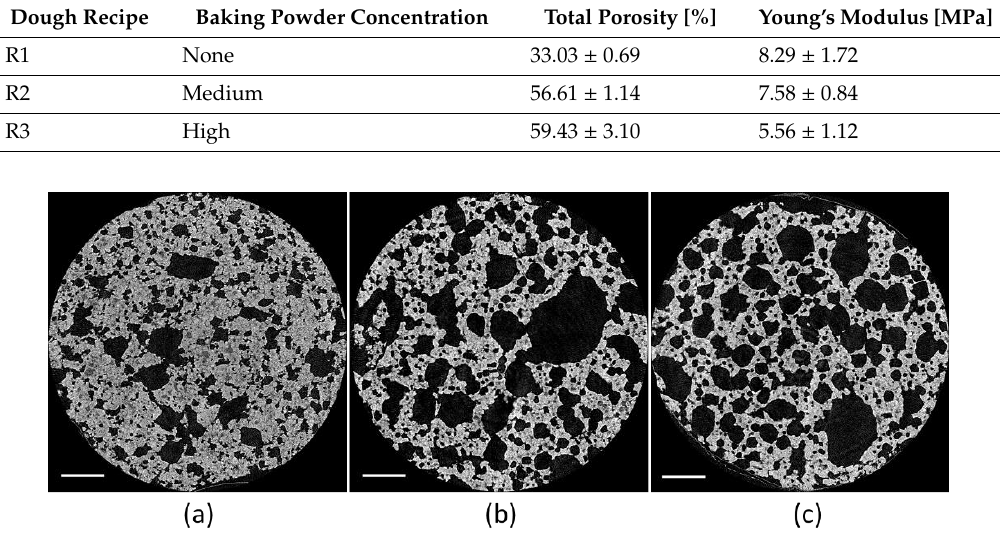
Table 1. Summary of the properties of the di ff erent cookie dough recipes used for the compression test.